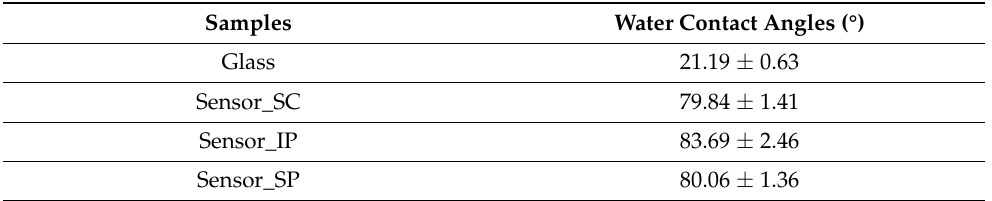
Table 2. Water contact angles (WCA) of substrates and optical sensor layers prepared with different techniques: spin coating (Sensor_SC), inkjet printing (Sensor_IP), and spray coating (Sensor_SP).